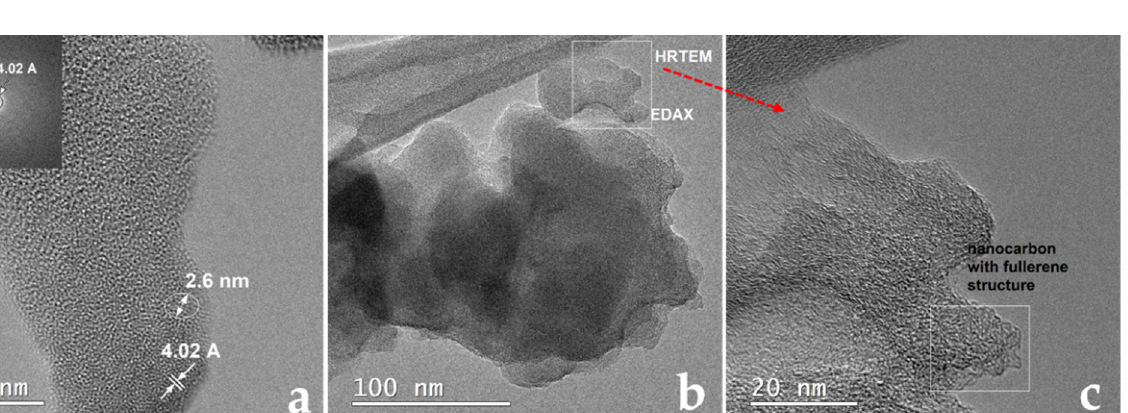
Figure 5. TEM image for the ( a ) C/SiO 2 -0.055 M at low magnification; HRTEM image for the ( b ) C/SiO 2 -0.055 M.